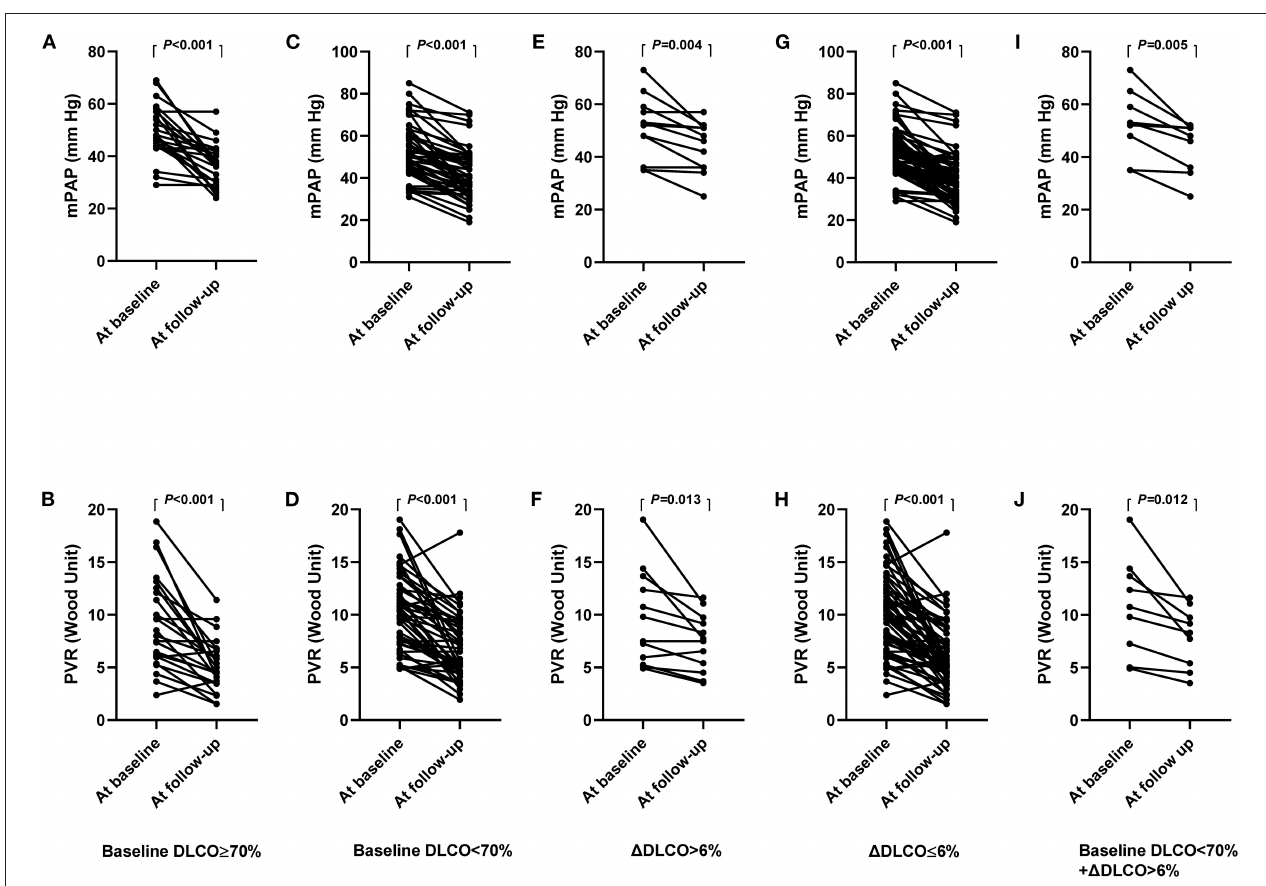
FIGURE 4 | (A–J) , hemodynamics at the baseline and follow-up, stratified by baseline DLCO and 1 DLCO. mPAP (A) and PVR (B) in patients with baseline DLCO ≥ 70%. mPAP (C) and PVR (D) in patients with baseline DLCO < 70%. mPAP (E) and PVR (F) in patients with 1 DLCO > 6%. mPAP (G) and PVR (H) in patients